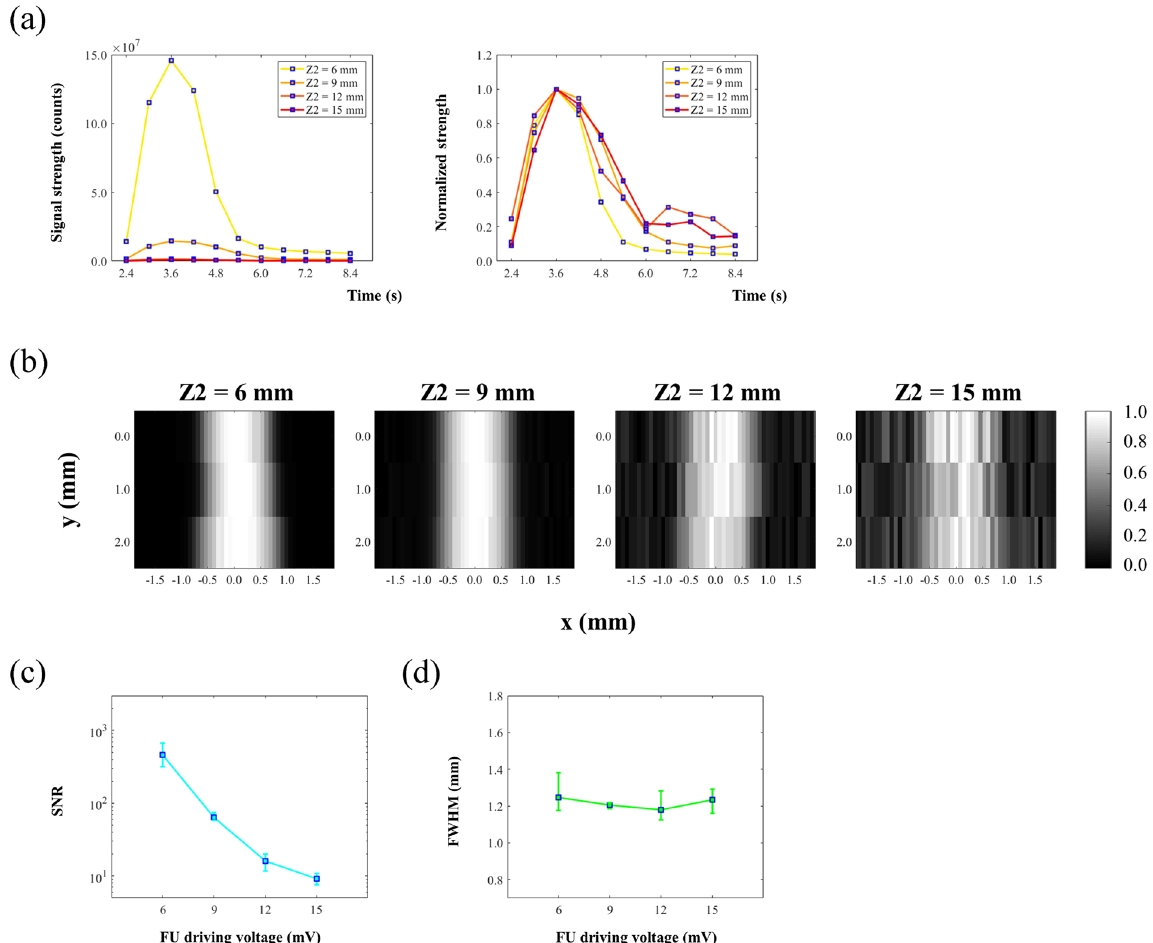
Figure 5. ( a ) USF signals acquired at x = 0.00 mm, y = 0.00 mm, in the four phantoms with different Z2 = 6, 9, 12 and 15 mm. In the left plot, it shows the USF signal strength significantly decreased with the increase of Z2. In the right plot it shows the normalized signal strengths over time: the USF signal duration changed slightly when the Z2 increased. ( b ) Normalized 2D USF images acquired at different imaging depth Z2 = 6, 9, 12 and 15 mm. ( c ) Relationship between SNR of imaged tube and imaging depth Z2. (d) Relationship between FWHM of imaged tube and imaging depth